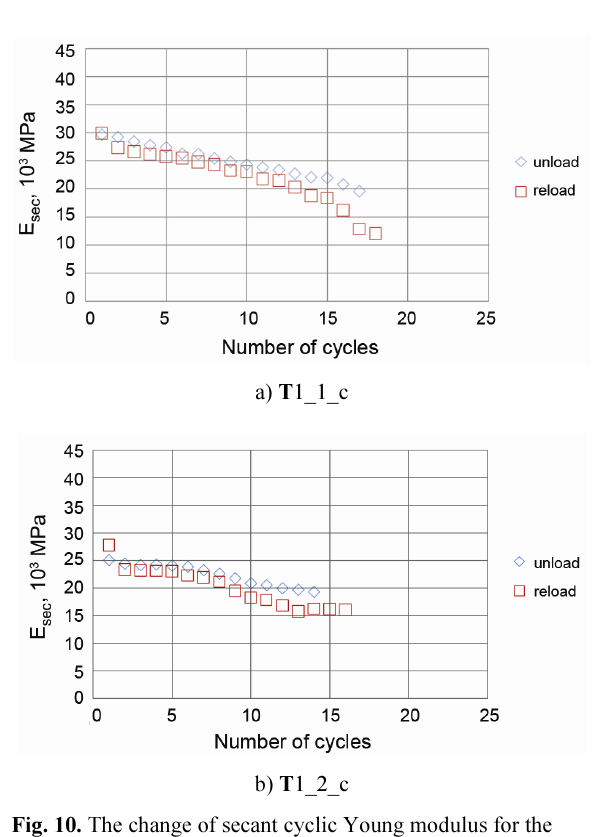
Fig. 10. The change of secant cyclic Young modulus for the specimens T 1_1_c and T